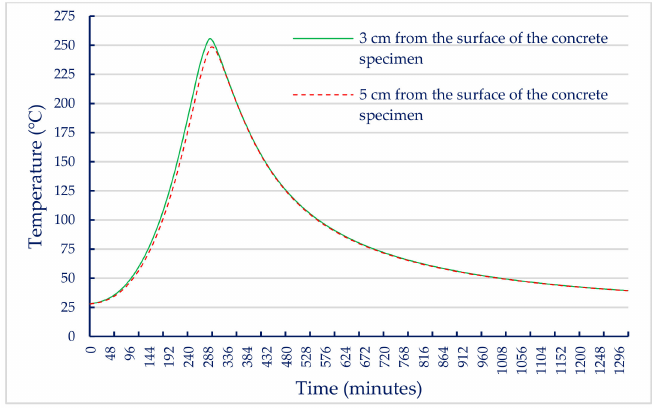
Figure 9. Relationship between specimen internal temperature and time (target temperature = 500 ◦